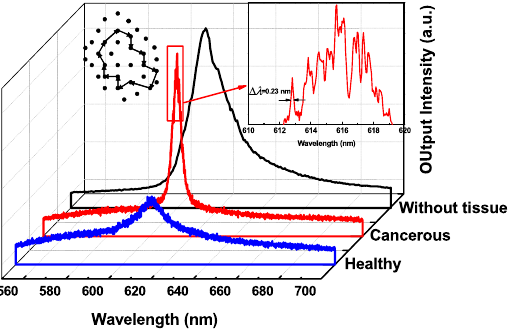
Figure 3. The emission spectra from the bare DCJTB doped PS film, and the emission spectra from the healthy and cancerous breast tissues marked with nanotextured DCJTB. The inset shows a portion of the spectrum of the nanotextured DCJTB embedded cancerous human tissue under higher magnification (right) and a schematic diagram showing the formation of a closed-loop path for light through multiple optical scatters